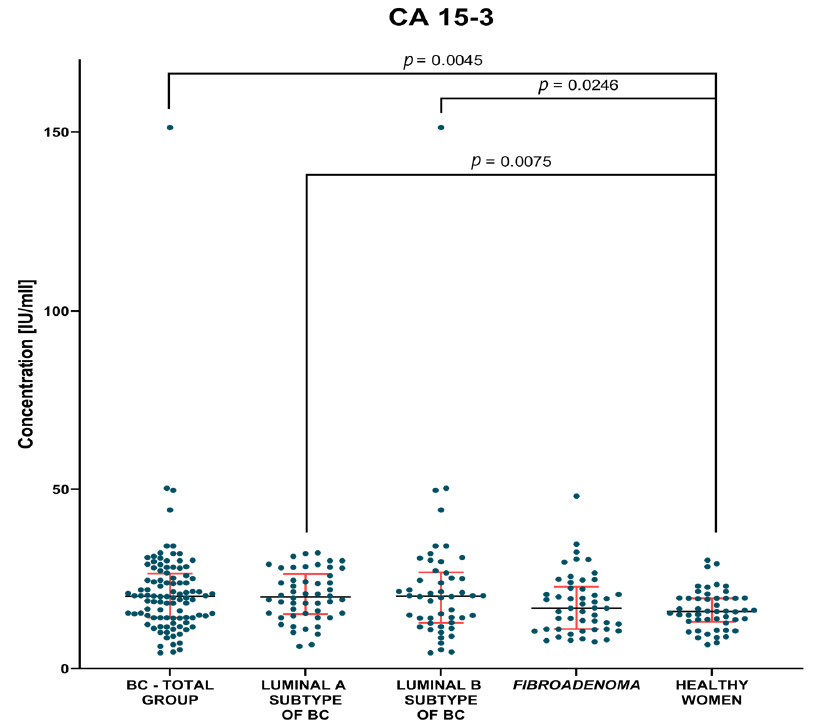
Figure 3. CA 15-3plasma concentrations (with marked median and interquartile range) in all tested groups: patients with BC, fibroadenoma subjects and healthy women. Significant statistical differences have been marked on the figure.